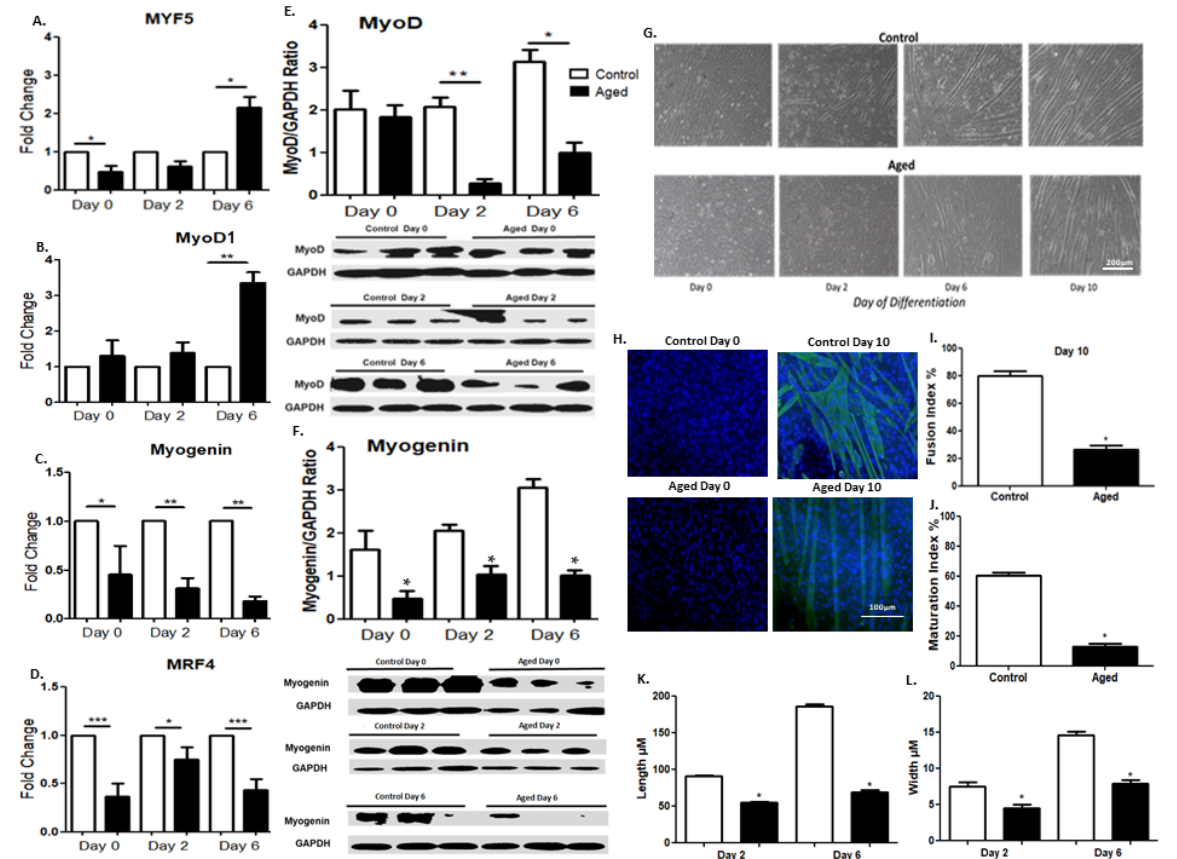
Figure 2. ( A – D ) Myogenic regulatory factor expression during myoblast differentiation. Quantitative analysis of the muscle-specific transcription factors MyF5 ( A ), MyoD ( B ), myogenin ( C ) and MRF4 ( D ) mRNA expression in aged myoblasts compared to controls during their differentiation processes. The mRNA expression values of MRFs in aged myoblasts have been normalized to the corresponding GAPDH mRNA and are expressed as fold changes compared to control cells. ( E , F ) Effects of myoblast aging on their expression of the myogenic regulatory factors MyoD and myogenin. Representative Western blots and immunoblotting quantification of MyoD ( E ) and myogenin ( F ) in aged myoblasts compared to control cells during their differentiation process. The values of the proteins of interest were normalized to each corresponding GAPDH on the same immunoblot. ( G ) Morphology-based analysis of control and aged C2C12 myoblasts during differentiation. Bright-field microscopy shows delayed myotubes formation in the aged myoblasts compared with the control cells over time, during myogenesis. ( H ) MyHC and DAPI immunostaining revealed a substantial reduction inmyotubes in aged cells. ( I ) Fusion index and ( J ) maturation index values were calculated in control and aged myotubes immunostained with MyHC. Myotubes were considered differentiated cells that contained more than three nuclei. The fusion index was defined as the percentage of nuclei present in myotubes over the total number of nuclei present in the observed field, while maturation index was defined as the percentage of nuclei present in myotubes that contained more than 10 nuclei over the total number of nuclei present in the observed field. ( K , L ) Morphological analysis of myotubes observed after 2 and 6 days of differentiation at both control and aged groups. Length and width of myotubes of each group have been measured and reported as mean values in the graph. Data wereselected from 10 different and randomly chosen microscopic fields. (Mean ± SE of 3 independent experiments performed in triplicate; * p < 0.05, ** p < 0.01, *** p